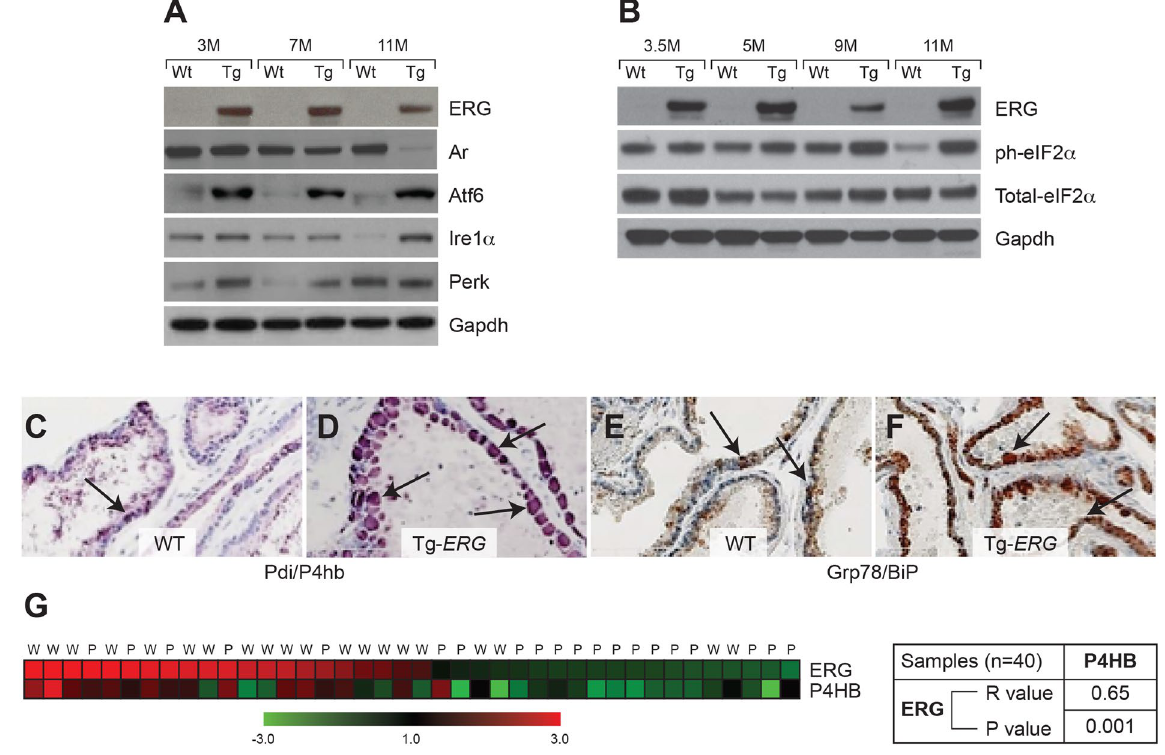
Figure 4. Regulation of ER stress sensors by ERG in mouse prostates. Western blot analysis (A) of ERG, Ar and ER stress sensors Atf6, Ire1 α and Perk show increased expression in 3, 7 and 11 month-old Tg-ERG mouse prostates. Ar expression appears to decrease in the Tg- ERG prostates and is more significant in older mice. Similarly, there is an increase in the phosphorylation of eIF2 α , a down stream target for Perk, in the transgenic mouse prostate glands ( B ). Immunohistochemical analysis of and P4hb/Pdi ( C,D ) and Grp78/BiP ( E,F ) in wild- type ( C,E ) and Tg- ERG ( D,F ) mouse prostates show elevated expression. Analysis of ERG and P4HB expression ( G ) in human prostate has shown significant correlation ( n ) (r = 0.65; P = 0.001). Expression data obtained from an 80GeneChip microarray show up-regulation as red and down-regulation as